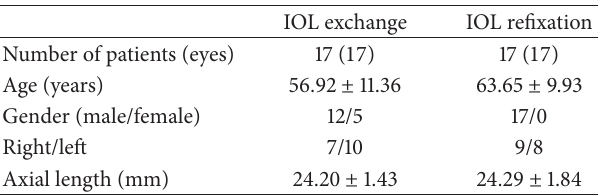
Table 1: Demographic characteristics of patients with IOL exchange and IOL refixation groups.